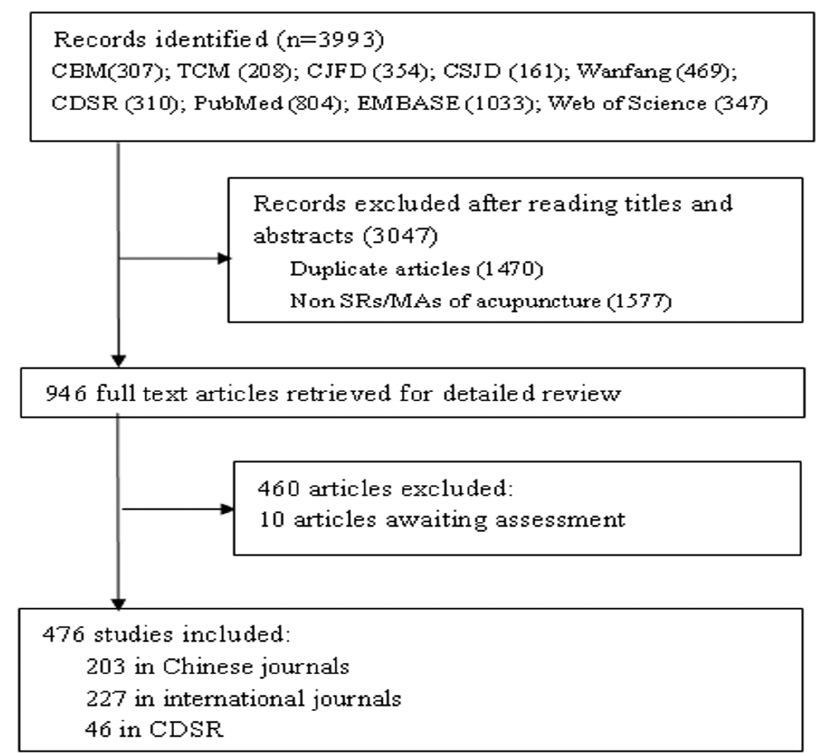
Figure 1. Flow chart of articles identified, included and excluded.